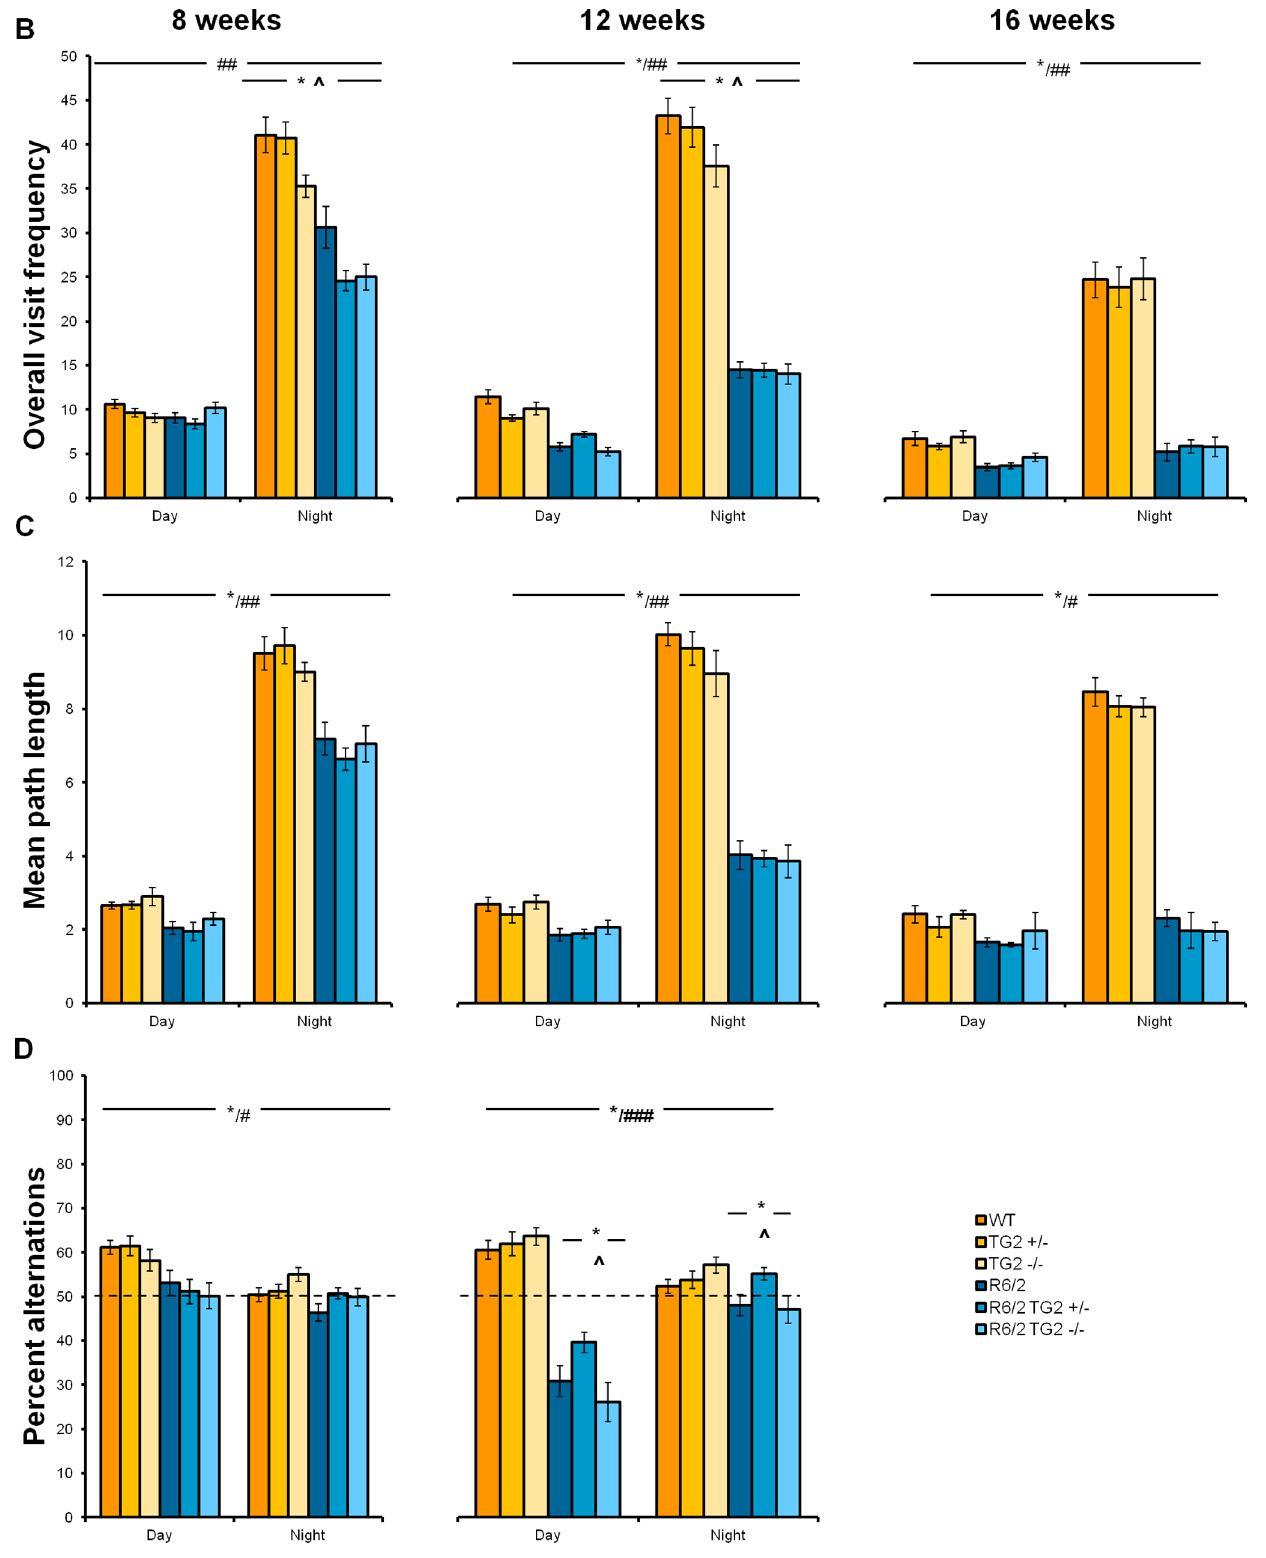
Figure 3. Behavioral data captured in the PhenoCube system as a function of genotype, age and light cycle phase in animals from the R6/2 6 TG2 KO line. A. Overall visit frequency. B. Mean path length. C. Percent alternations (Data for this measure were not collected at 16 weeks of age since R6/2 mice were not tested in this protocol due to reduced licking). *Significant HD genotype differences within each light phase, at each age; # : significant differences due to light phase in the diurnal cycle in the WT mice; ## significant differences due to light phase in the cycle